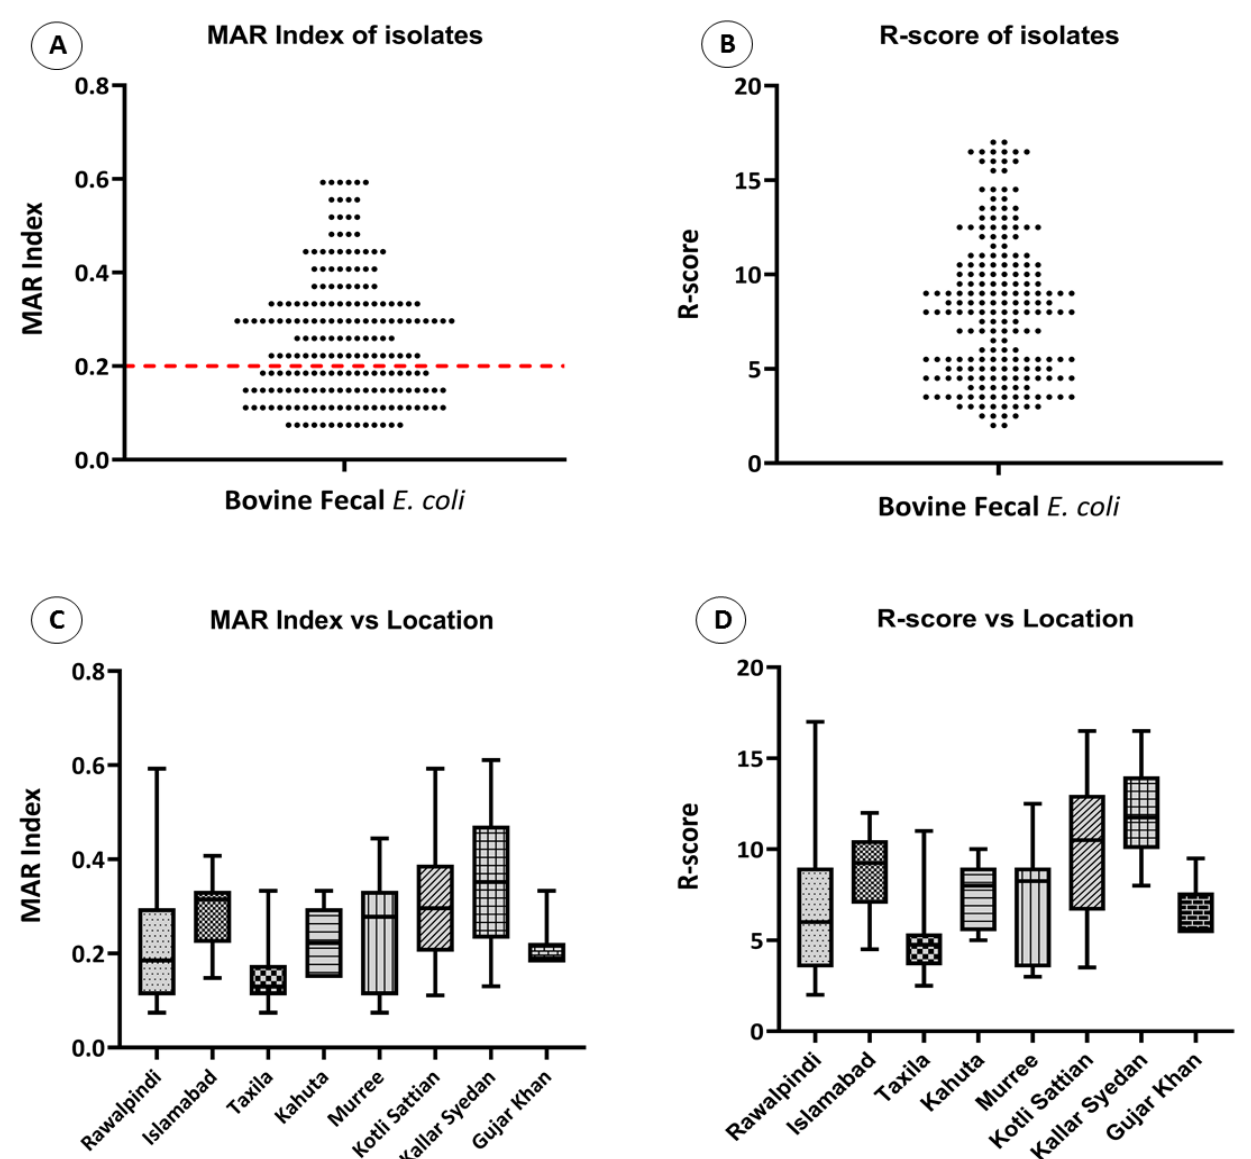
Figure 5. Phenotypic associations. ( A ) Scatter plot showing the MAR index of bovine fecal E. coli isolates. Dots representing each isolate’s response show the variability and distribution of data. The isolates above the red line are considered highly resistant, ( B ) scatter plot showing the R-Score of E. coli isolates. Dots representing each isolate’s response show the variability and distribution of data, ( C ) box plot showing the comparison of the MAR index of various locations from which the bovine fecal E. coli isolates were collected, and ( D ) box plot showing the comparison of R-Scores of various locations from which the E. coli isolates were collected.